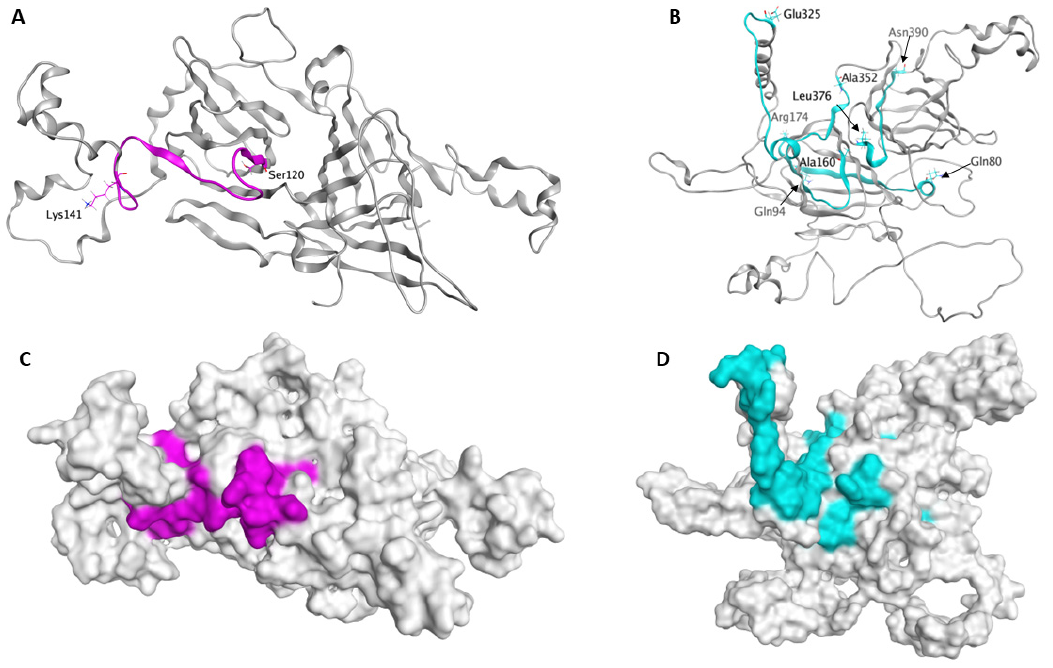
Figure 4. Cottonseed C72 Vicilin and Legumin B Models. Ribbon and space filling models of the